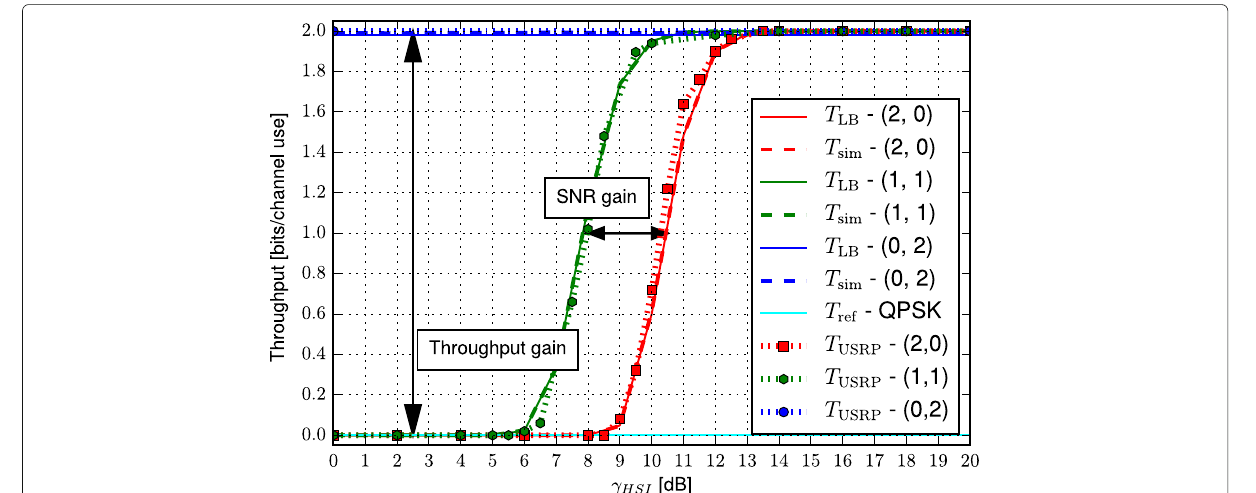
Fig. 8 Comparison of throughput as a function of γ HSI for γ MAC = 20dB, γ BC = 20dB and given ( N b , N s )